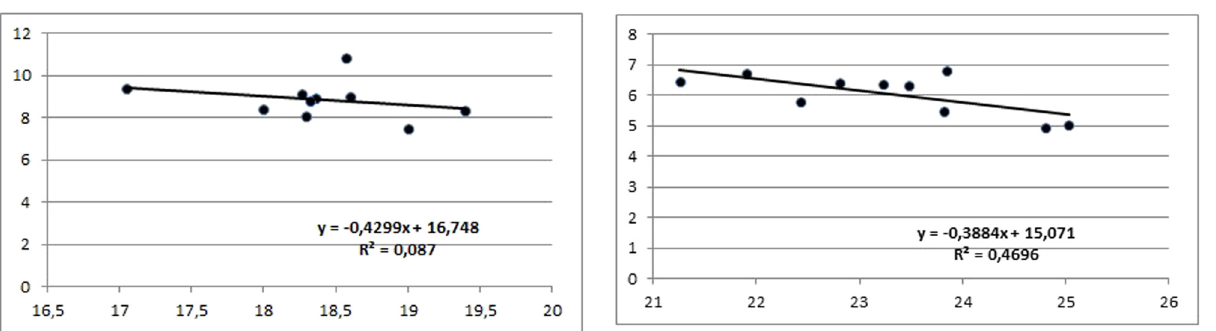
Figure 4: Linear approximation of the dependence of meat content on fat content in the pelvic - femoral third of the carcass at a slaughter weight of 120 kg.